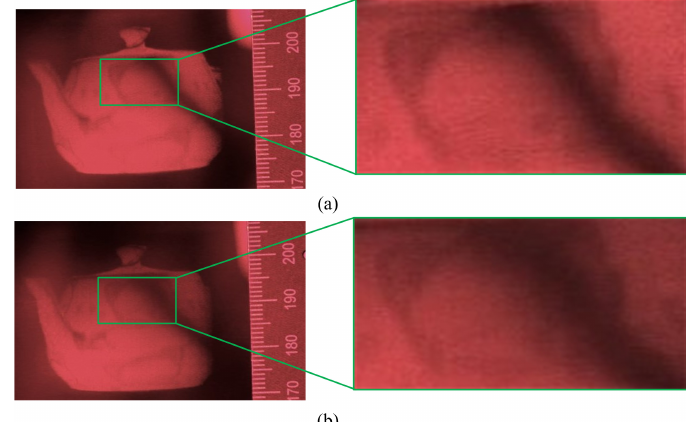
Figure 14. Comparison of details between reconstructed images of the EPISM method and reconstructed images of the holographic element-based EPISM method ( a ) Details of reconstructed images of the EPISM method ( b ) Details of reconstructed images of the holographic element-based EPISM